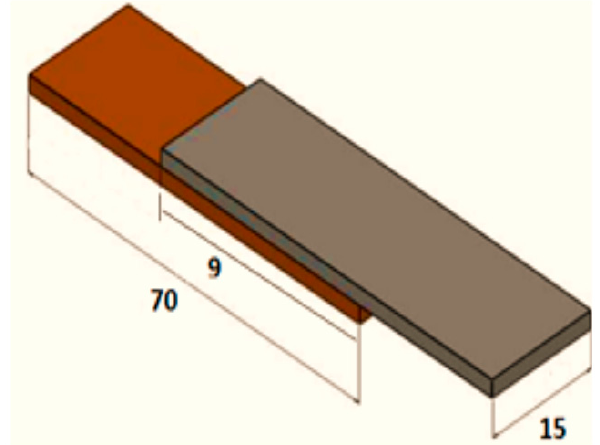
Figure 4. Setup for clamping FSW sample.